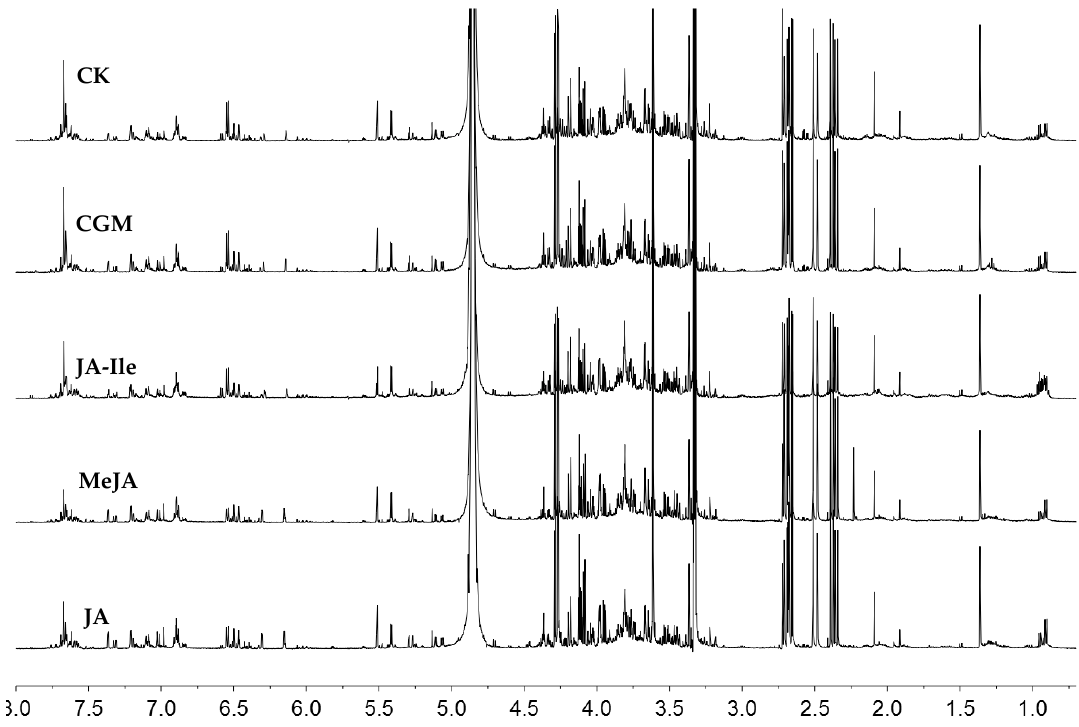
Figure 3. 1 H-NMR spectra comparison of L. leucocephala leaf extracts under different elicitors.